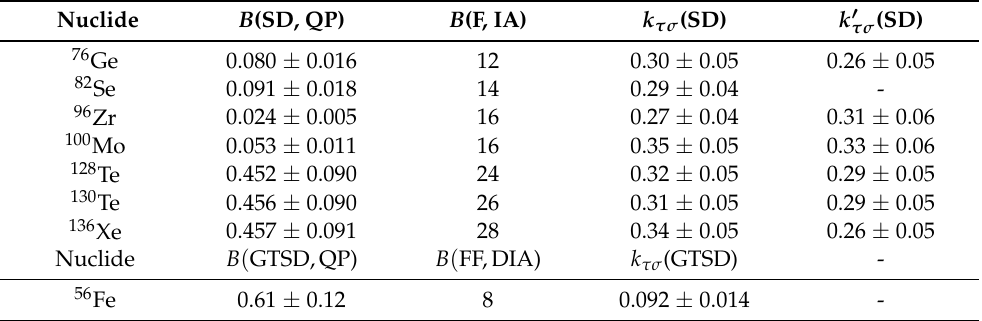
Table 1. Top: The SD strengths and the reduction coefficients for the QP and low-lying states by SCERs on DBD nuclei. The SD strength B (SD,QP), the F strength B (F,IA), the reduction coefficient k τσ (SD) are shown for the QP states, and the reduction coefficient k (cid:48) τσ (SD) for the low-lying states. See text. Bottom: the GT-SD strength and the reduction coefficient for the QP states by DCER on 56 Fe. The GT-SD strength B (GTSD,QP), the F strength B (FF,DIA), and the reduction coefficient k τσ (GTSD) are